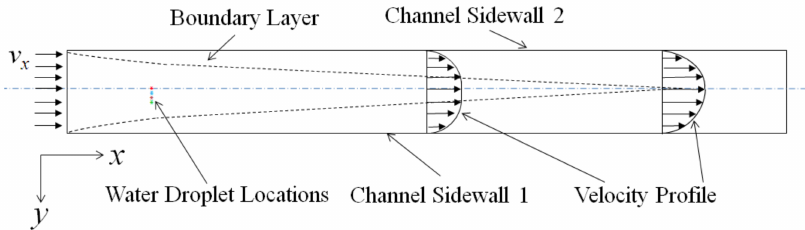
Figure 3. Illustrations of the initial water droplet locations, gas boundary layer, and velocity profiles in the middle z plane of the gas flow channel. The water droplet location is represented by the water spreading center on the MEA